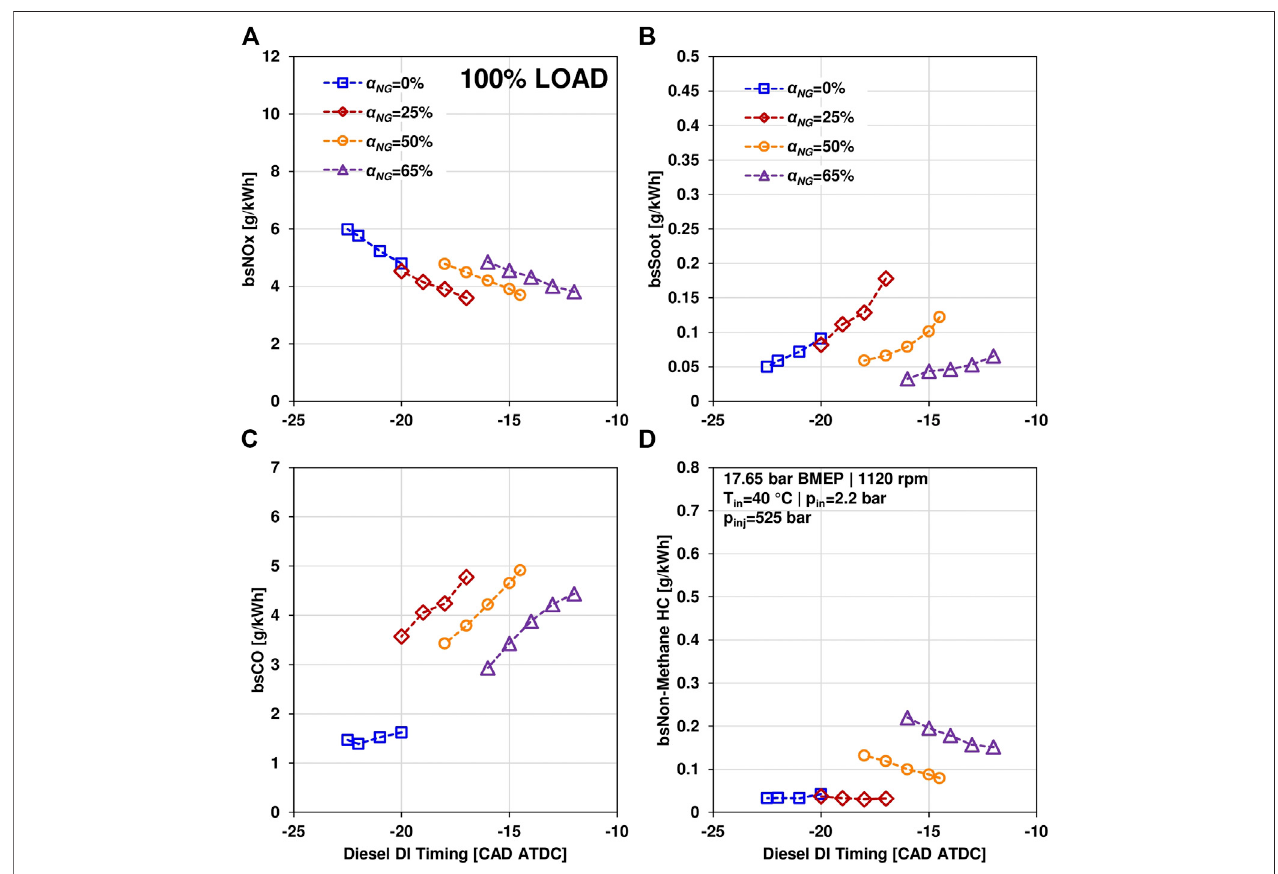
FIGURE 12 | Exhaust emissions at 100% load – (A) . NOx; (B) . Soot; (C) . CO; (D) . Non-methane